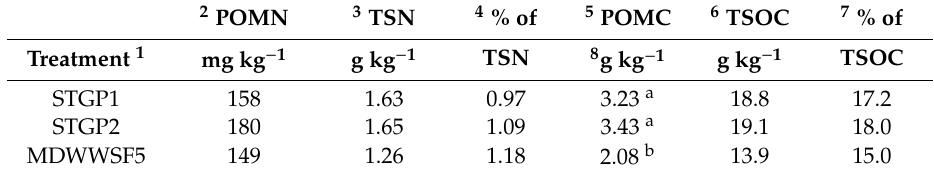
Table 2. Measurements of particulate organic matter nitrogen 2 (POMN), POMN as a fraction of total soil nitrogen 3 (TSN), POMN as a percent of total soil N 4 (% of TSN), particulate organic matter carbon 5 (POMC), total soil organic C 6 (TSOC) and POMC as a percent of total soil organic C 7 (% of TSOC). 2 POMN 3 TSN 4 % of 5 POMC 6 TSOC 7 % of Treatment 1 mg kg − 1 g kg − 1 TSN 8 g kg − 1 g kg − 1 TSOC STGP1 158 1.63 0.97 3.23 a 18.8 17.2 STGP2 180 1.65